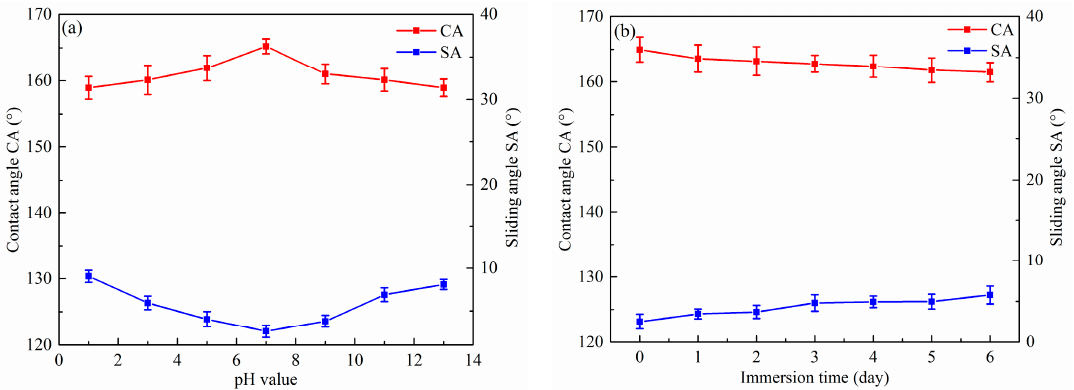
Figure 6. Influence of pH values ( a ) and immersion time in water ( b ) on the CA and SA of the as-prepared superhydrophobic surfaces with BS.